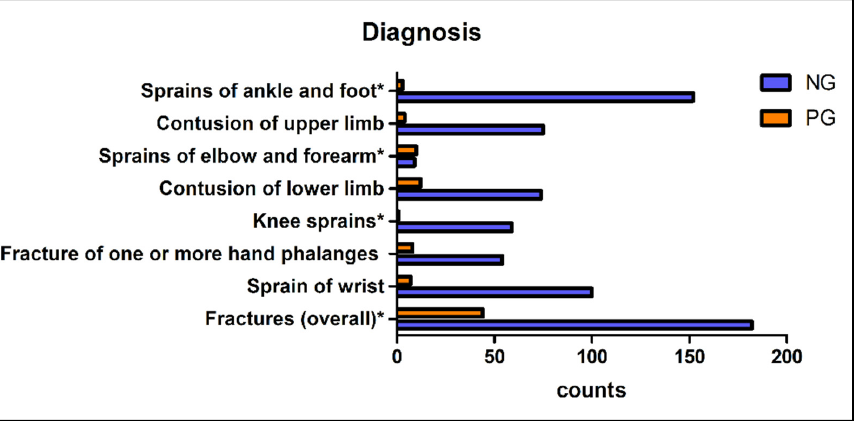
Figure 2. Most frequent diagnosis: differences between NG and PG. * = statistically significant difference. Legend: NG: Non-pandemic Group PG: Pandemic